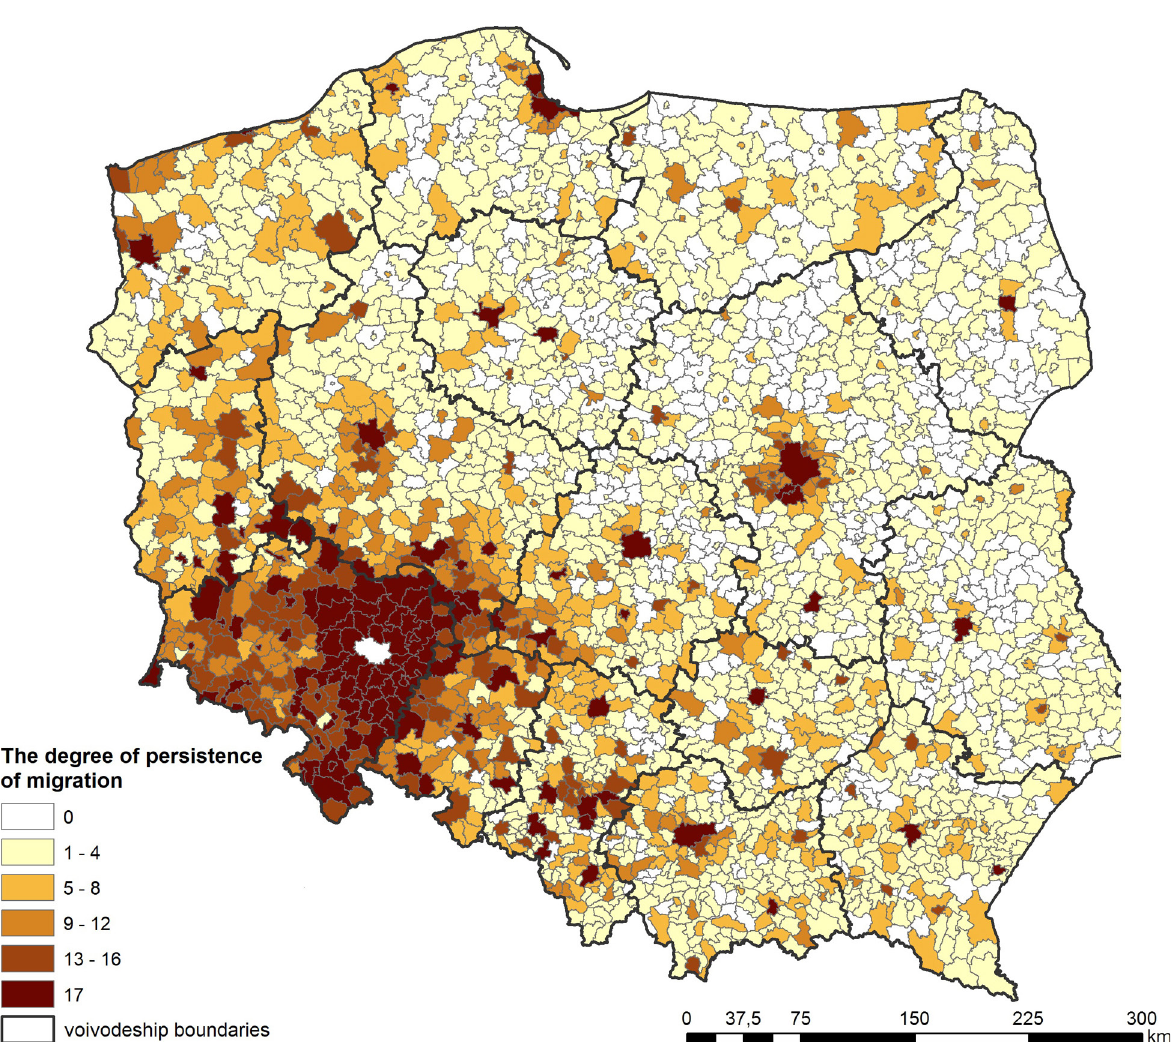
Fig. 7. The persistence of migration from Wrocław in the years 2002–2018 per